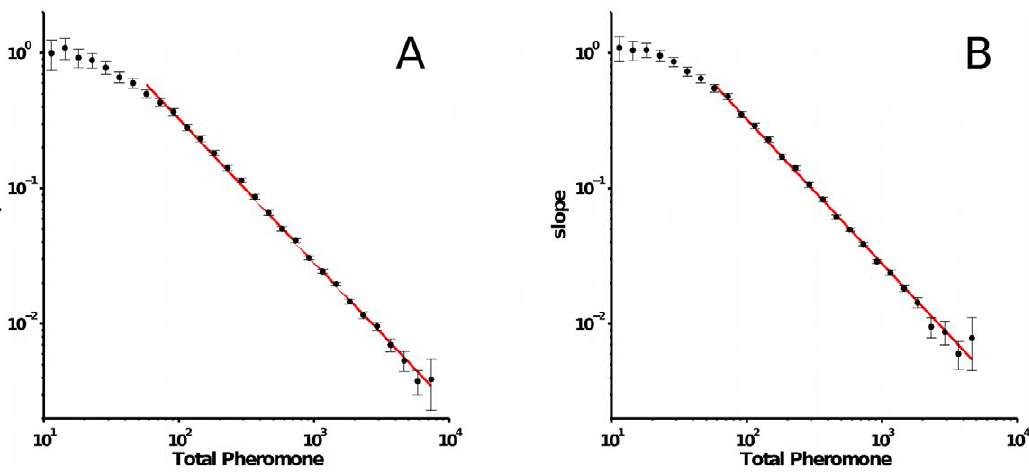
Figure 6. Log-log plot of the slope k of the angle change k ~ a = ( L { R ) vs. the total pheromone around one ant ( L z R ) . Error bars associated with each data point are 95% confidence intervals on the slope estimation. A. no pheromone evaporation. B. pheromone evaporation with half-life of 30 min. The red line is a power-law fit of the form (non-weighted linear least squares of the log-transformed data; fitting parameters for the curve in A: A ~ 42 : 41(95% CI : 36 : 90,48 : 74) ; b ~ 1 : 058(95% CI : 1 : 079,1 : 037) ; R 2 ~ 0 : 9982 ; F 20,1 ~ 11084 ; p v 0 : 001 . curve in B: A ~ 43 : 46(95% CI : 34 : 13,55 : 34) ; b ~ 1 : 064(95% CI : 1 : 102,1 : 026) ; R 2 ~ 0 : 9949 ; F 18,1 ~ 3489 ; p v 0 : 001 ); fit restricted to the data point with L z R w 50 pheromone units. Assuming b ~ 1 and fitting directly a function of the form a ~ A 0 L { R ð Þ = L z R z T 0 ð